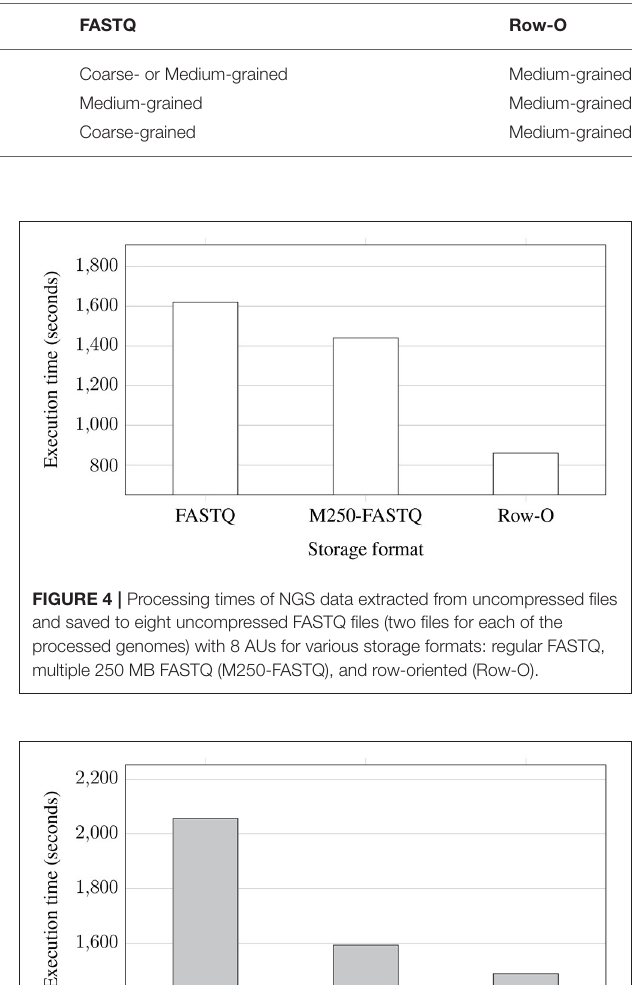
data sets (SRR988072, SRR988073, SRR988074, and